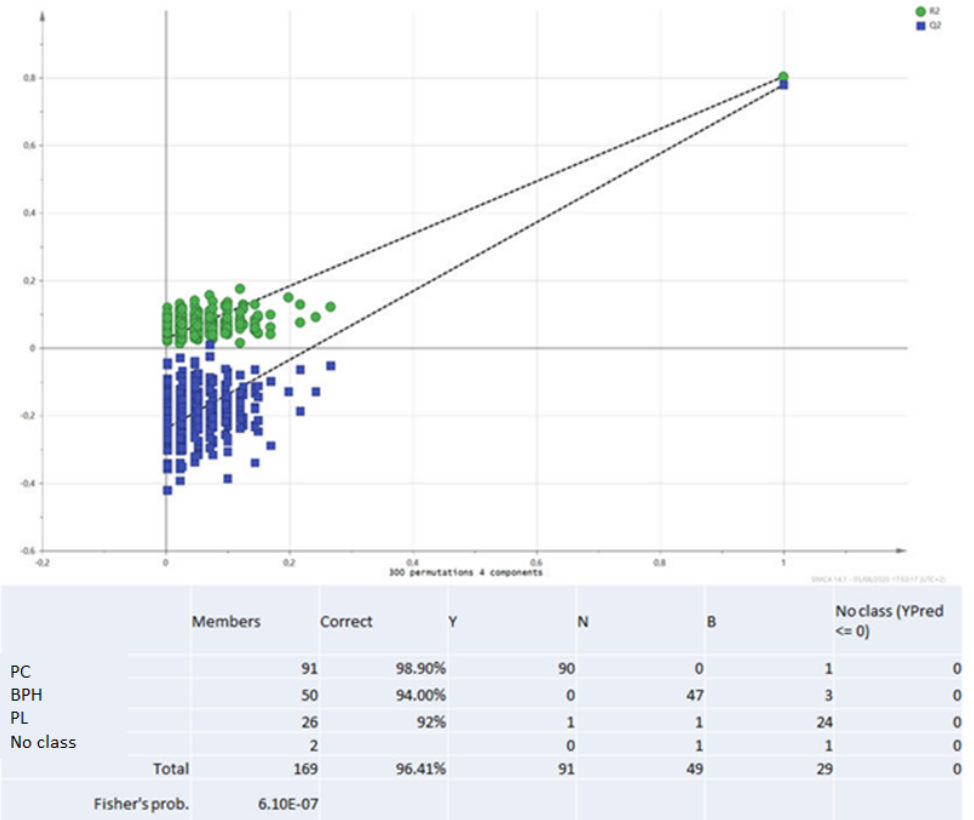
Figure 5. Validation method: 300-fold cross permutation validation plot. The Y-axis represents R2 (triangles) and Q2 (circles) for the model, and the X-axis designates the correlation coefficient between original and permuted response data.